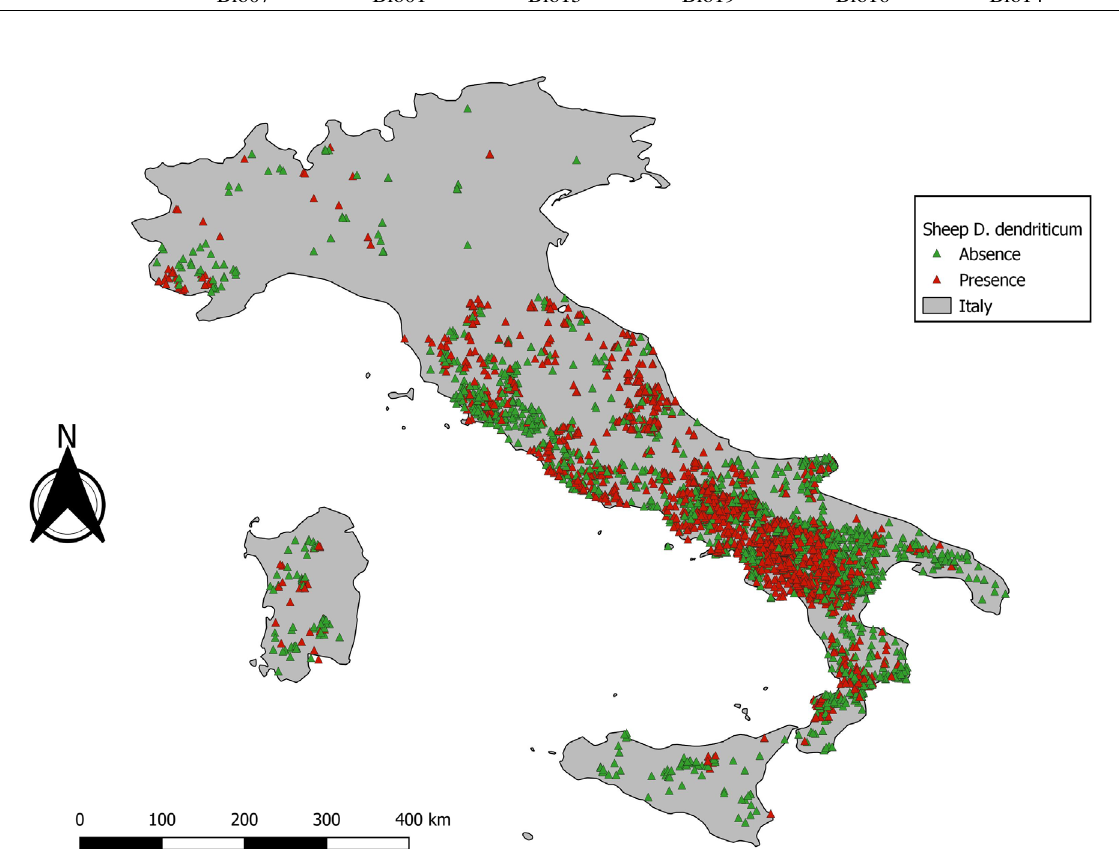
Figure 3. Data distribution for Dicrocoelium dendriticum from 1999 – 2018.